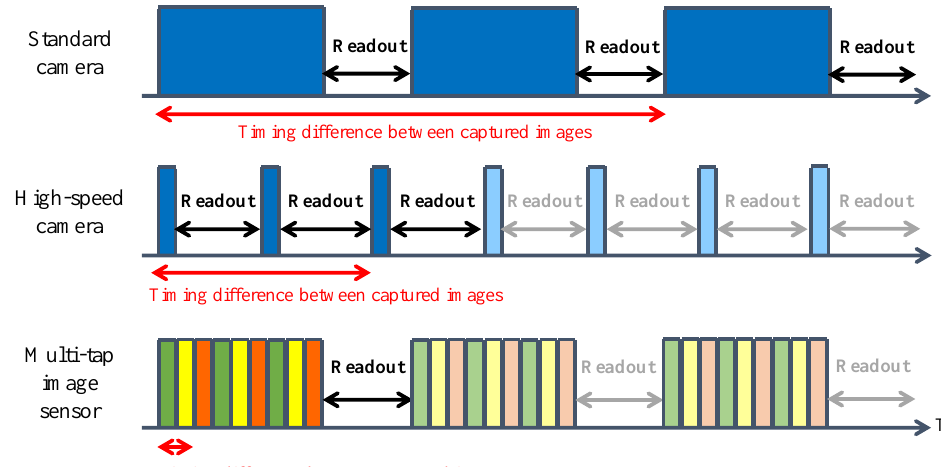
Figure 3. Timing diagram comparison of the exposure and readout times for a standard camera, a high-speed camera, and the multi-tap CMOS image sensor. In the time taken for a standard camera to capture one image, a high-speed camera can capture several images. However, the exposure time of such a camera must be short and the signal-to-noise ratios (SNRs) of the captured images are low. Multi-tap image sensors can acquire almost identical images through iteration of the short exposure time with a high SNR. In this diagram, a three-tap image sensor is used as the multi-tap complementary metal-oxide-semiconductor (CMOS) image sensor.